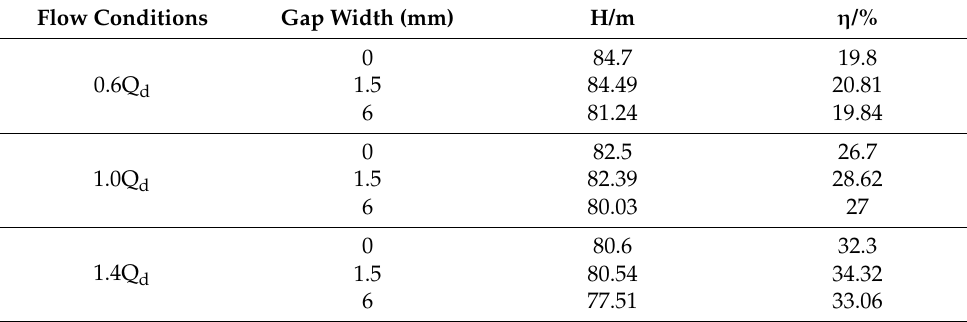
Table 3. Comparison of hydraulic performance of different